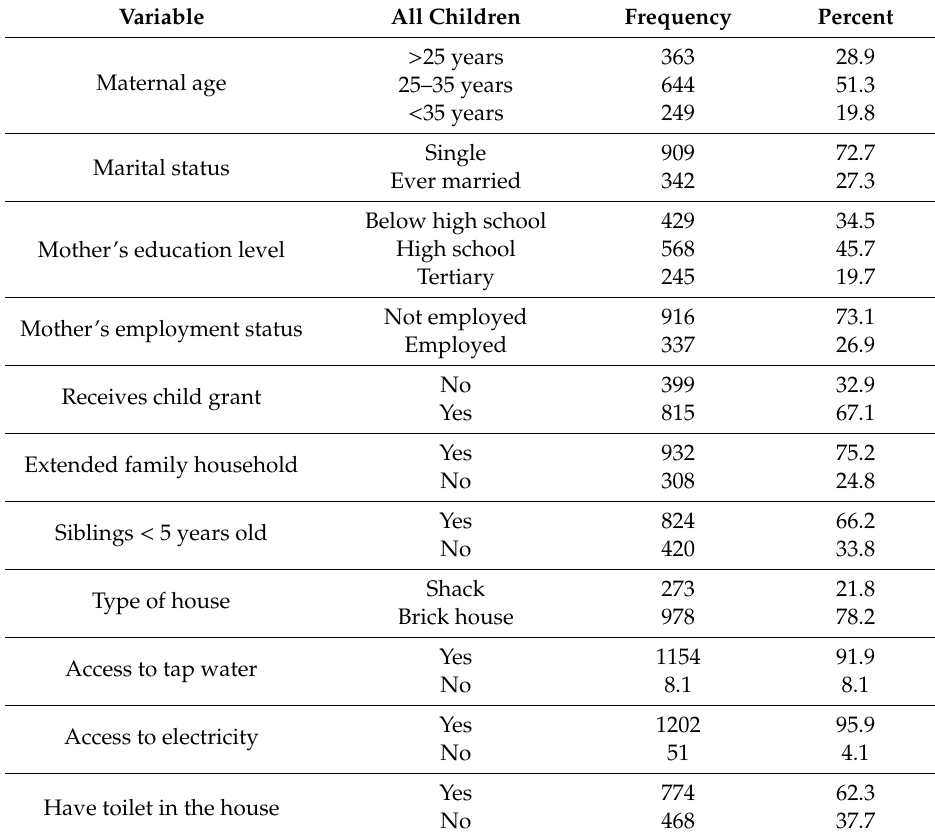
Table 1. Socio-demographic characteristics of mothers of children under five years of age in health facilities.